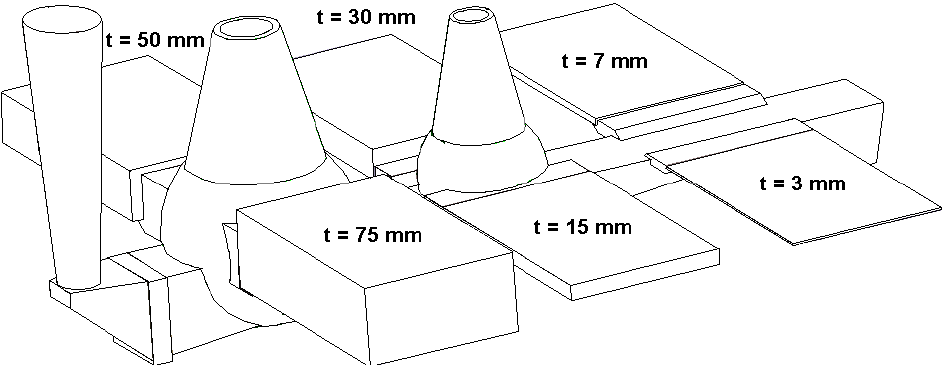
Figure 1. A schematic illustration of the cast